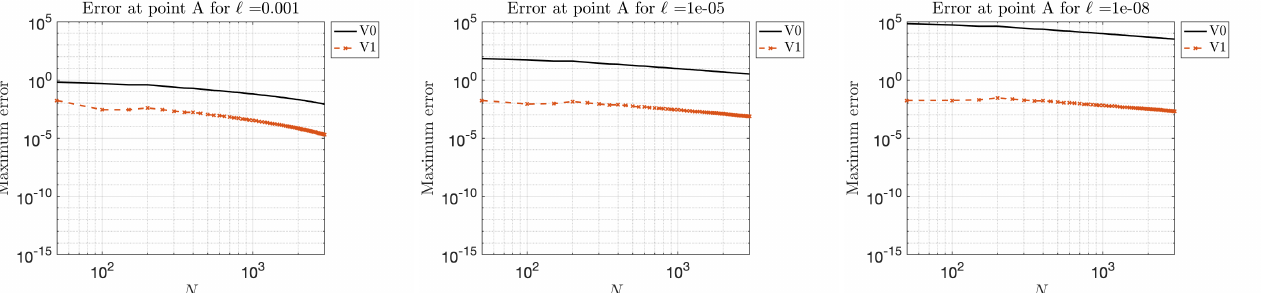
Figure 7. Helmholtz 2D. Log-log plots of the errors made in computing the solution along the normal of the three points A, B, C, plotted as black × ’s in Figure 6.